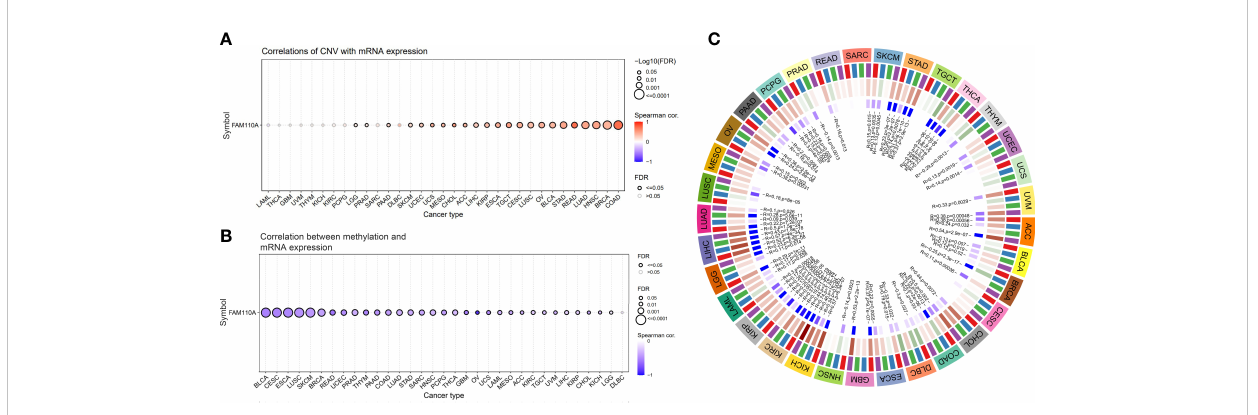
FIGURE 3 CNA and methylation contribute to driving the abnormal expression of FAM110A in pan-cancers. (A) Correlation of CNV and FAM110A mRNA expression in the GSCA database. A signi fi cant positive correlation was observed in patients with COAD, BRCA, HNSC and LUAD. (B) In most tumor types except DLBC, FAM110A mRNA expression was signi fi cantly associated with methylation levels, the strongest correlation was observed in BLCA, CESC, ESCA, LUSC, and SKCM. (C) Correlation of FAM110A mRNA with four methyltransferases, namely DNMT1 (Red), DNMT2 (Blue), DNMT3A (Green) and DNMT3B